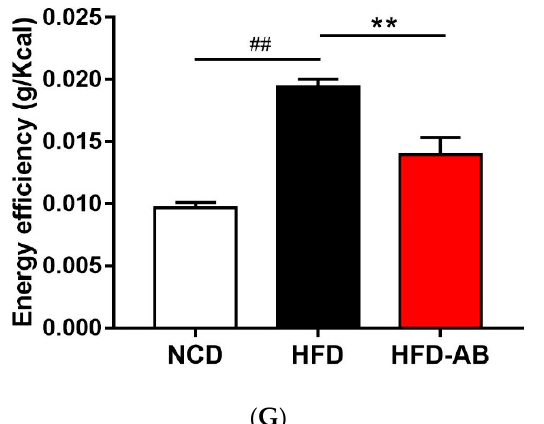
Figure 1. Adzuki bean supplementation prevented HFD-induced obesity. ( A ) Representative pictures of each group taken at the end of the experiment; ( B ) body weight evolution; ( C ) 12-week weight gain; ( D ) the mass of perirenal white adipose tissue (Per-WAT), epididymal white adipose tissue (Epi-WAT), and retroperitoneal white adipose tissue (Retro-WAT); ( E ) body fat ratio; ( F ) total energy intake; and ( G ) energy efficiency. Values are expressed as mean ± SEM, n = 8 per group. ## p < 0.01, HFD compared with NCD mice. * p < 0.05 and ** p < 0.01, HFD-AB compared with HFD mice. NCD, normal